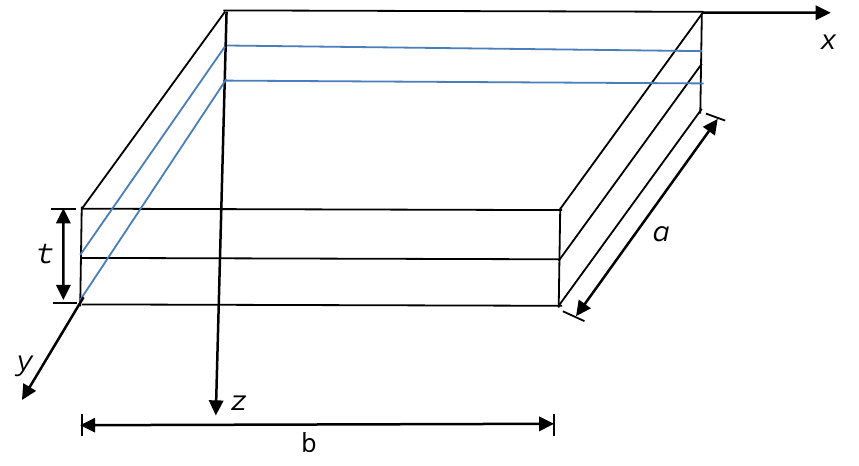
Figure 1. An element of thick rectangular plate showing middle surface